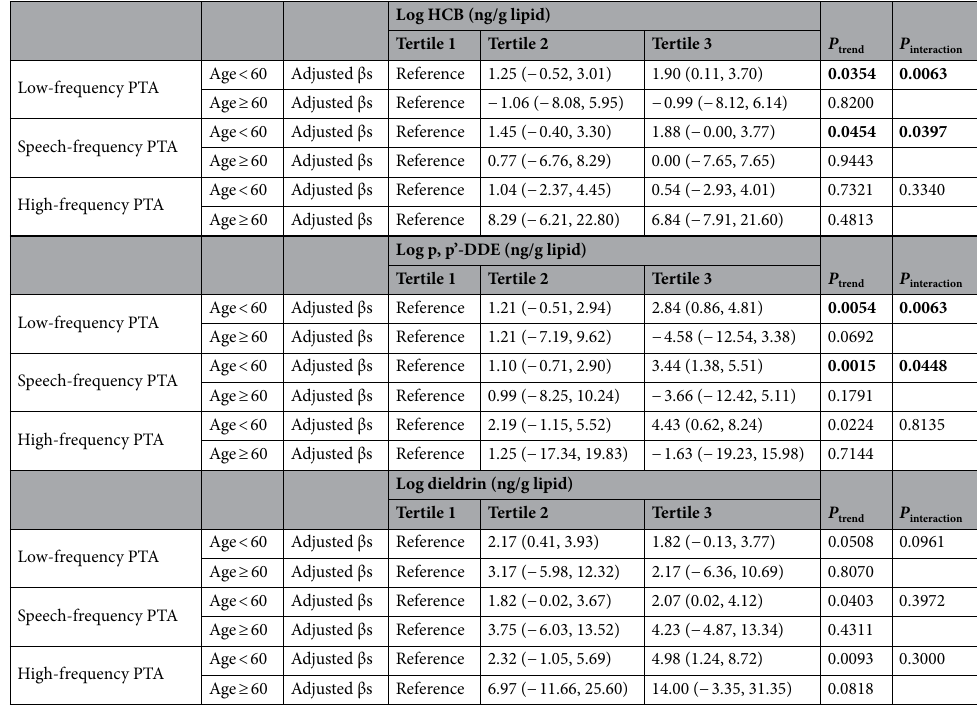
Table 3. Adjusted associations between OCPs and hearing threshold shifts stratified by age (N = 366): age < 60 group (N = 308) and age ≥ 60 group (N = 58). Adjusted for gender, race, education level, BMI, diabetes, hypertension, cotinine, firearm noise exposure and loud noise/music exposure. OCPs organochlorine pesticides, HCB hexachlorobenzene, p, p’-DDE p, p’-dichlorodiphenyldichloroethylene, BMI body mass index, PTA pure-tone average. Significant values are in